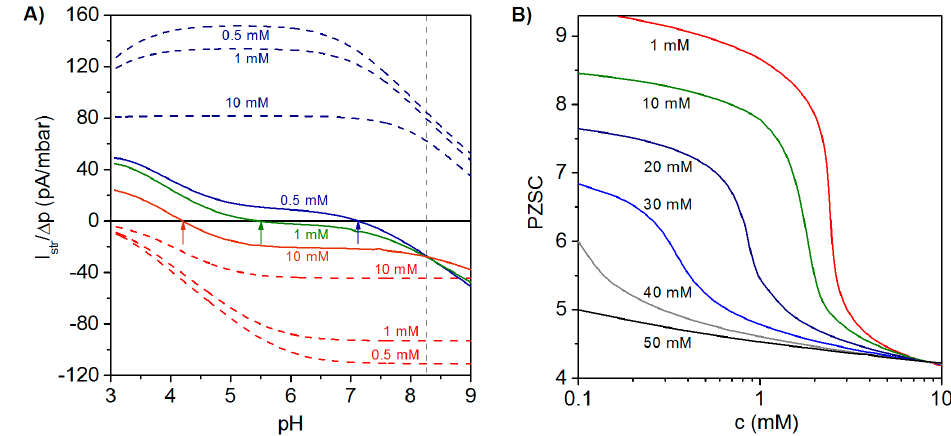
Figure 5. ( A ) Ratio of streaming current over applied pressure ( I str { ∆ P ) vs. pH evaluated at three electrolyte concentrations (indicated) for a polycationic layer (blue dashed lines), a polyanionic layer (red dashed lines) and a polycation ( j “ 1 )/polyanion ( j “ 2 ) bilayer film (colored solid lines). Model parameters for the bilayer system: p K 1 “ 9, ε 1 “ ` 1, δ 1 “ 30 nm, p K 2 “ 4, ε 2 “ ´ 1, δ 2 “ 5 nm, ˇ ˇ “ 20 mM, 1 { λ 1,2 “ 4.5 nm; in each layer, a homogeneous distribution of polymer segments is considered. Model parameters for the polycation layer and polyanion layer are similar to those adopted for the polycationic and polyanionic layers forming the bilayer film. Arrows highlight the decrease of point of zero streaming current (PZSC) for the bilayer film with increasing electrolyte concentration. ( B ) PZSC vs. electrolyte concentration for a bilayer system consisting of a polycationic layer with fixed charge density and a polyanionic layer with varying charge density (indicated in terms of equivalent concentration of charges). Other parameters as in the left panel. Adapted with permission from [27].